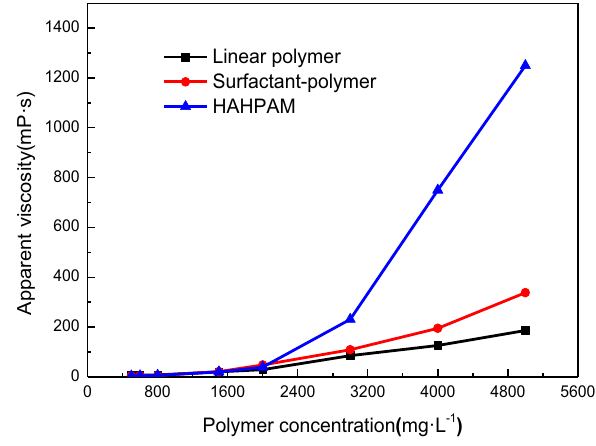
Fig. 3 Apparent viscosity plotted as a function of concentration for HAHPAM, surfactant–polymer, and linear polymer in brine (salin- ity = 9000 mg L −1 , [Ca 2+ ] + [Mg 2+ ] = 900 mg L −1 , T = 65 °C, concen- trations vary from 0.05 to 0.5 wt%, ̇𝛾 = 7.34 s −1